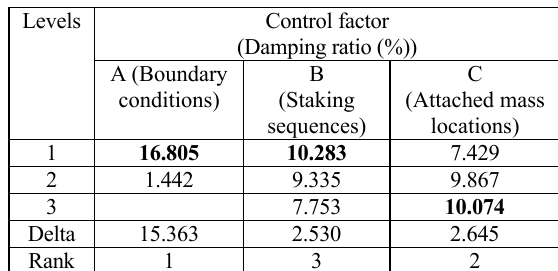
Table 10. S/N response table for the damping ratio of the fundamental mode